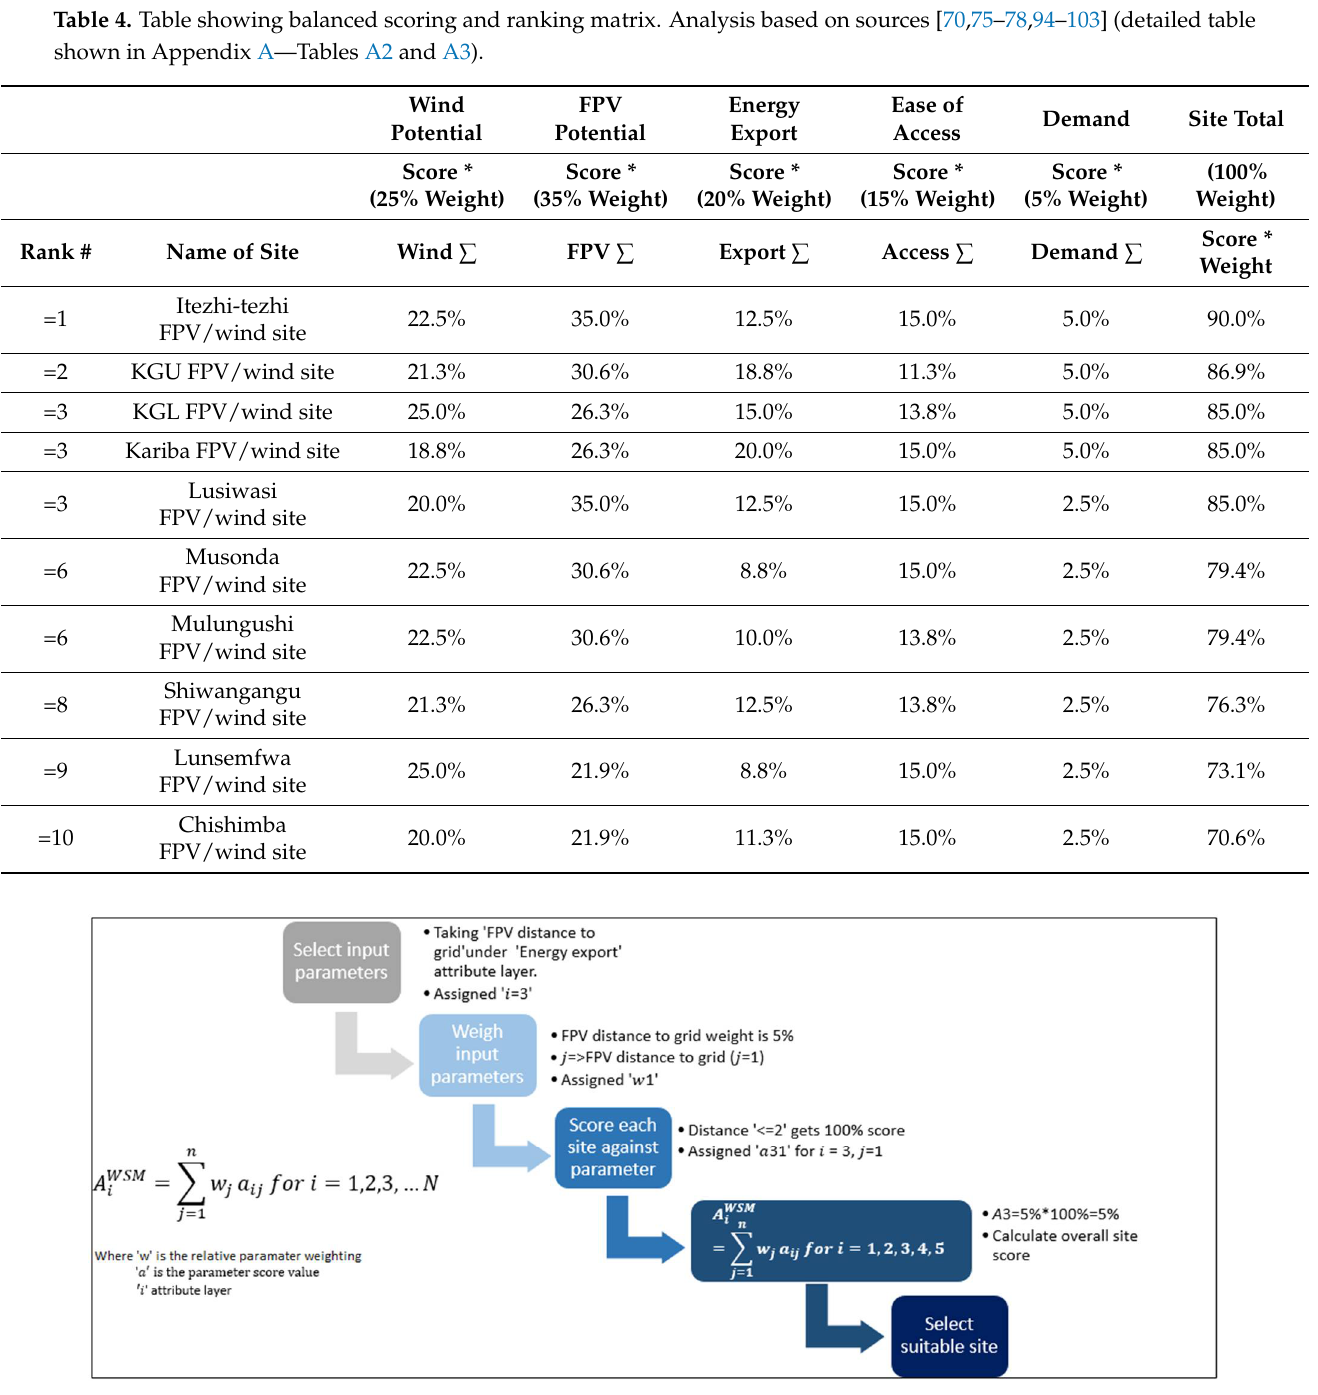
Figure 7. Diagram showing the application of the weighted sum equation under balanced scoring and ranking.